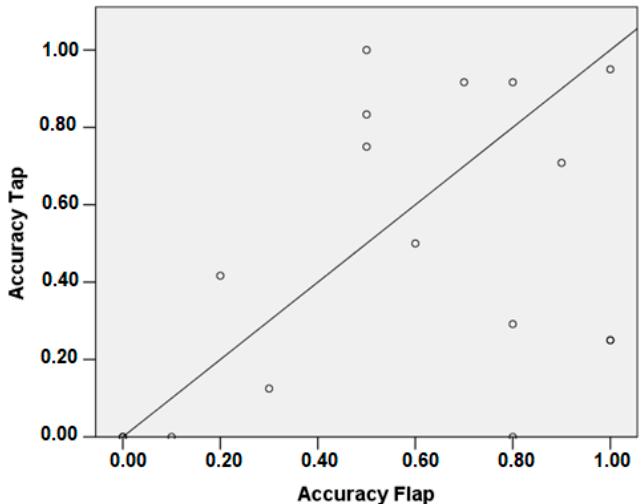
Figure 3. Comparison of the production accuracy rate of the L3 Spanish tap ( Y -axis) with the production accuracy rate of the L2 English flap ( X -axis), produced by L1 Mandarin–L2 English–L3 Spanish speakers ( n = 17).